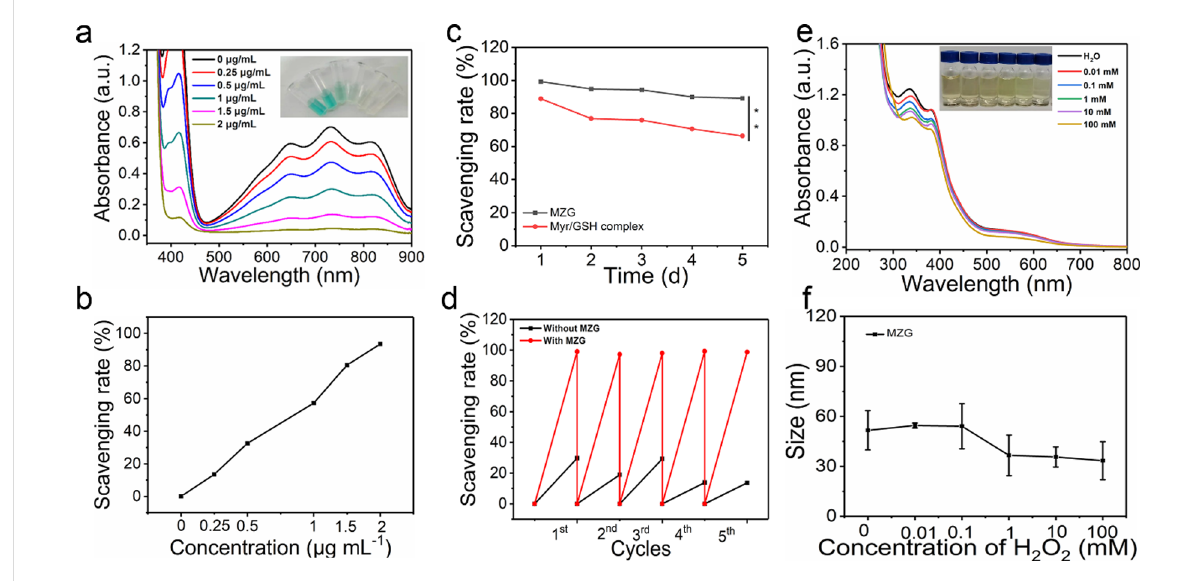
Figure 3: Measurement of ROS scavenging. (a) UV–vis absorption spectra of ABTS solution incubated with different concentrations of MZG nanopar- ticles for 5 min (a sample picture is shown in the inset, equivalent concentration of Myr: 0.25, 0.5, 1, and 2 µg·mL − 1 ). (b) The scavenging rate of MZG nanoparticles as fitted by the maximum UV–vis absorption at 734 nm. (c) Stably scavenging radical activity evaluation of MZG nanoparticles and Myr/ GSH complex (equivalent concentration of Myr: 4 μ g·mL − 1 , ** indicates p < 0.01). (d) Evaluation of the sustainable radical scavenging activity of MZG nanoparticles (equivalent concentration of Myr: 4 μ g·mL − 1 ). (e) UV–vis absorption spectra of MZG nanoparticles treated with different concentrations of H 2 O 2 (equivalent concentration of Myr: 20 μ g·mL − 1 ). (f) Size of MZG nanoparticles treated with different concentrations of H 2 O 2 (equivalent con- centration of Myr: 0.5 mg·mL − 1